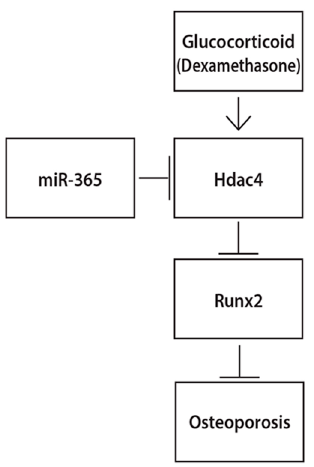
Figure 7. Schematic diagram showing the possible mechanisms by whichmiR-365 ameliorates DEX-induced osteoporosis. → means increase, ┫ means inhibition.